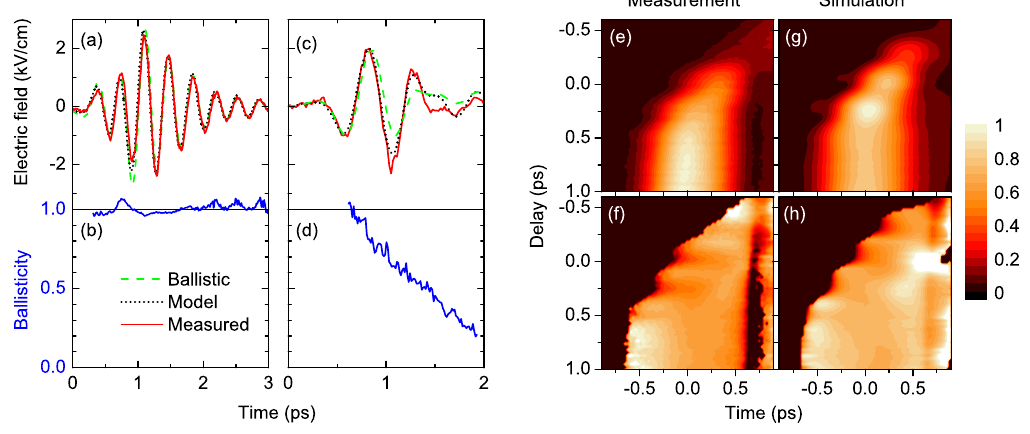
Fig. 1. (a)–(d) Electric fields emitted by the photocarriers for an incident THz field strength of 25 kV / cm. The free carriers were generated with a photoexcitation wavelength of 885 nm and an excitation density of n